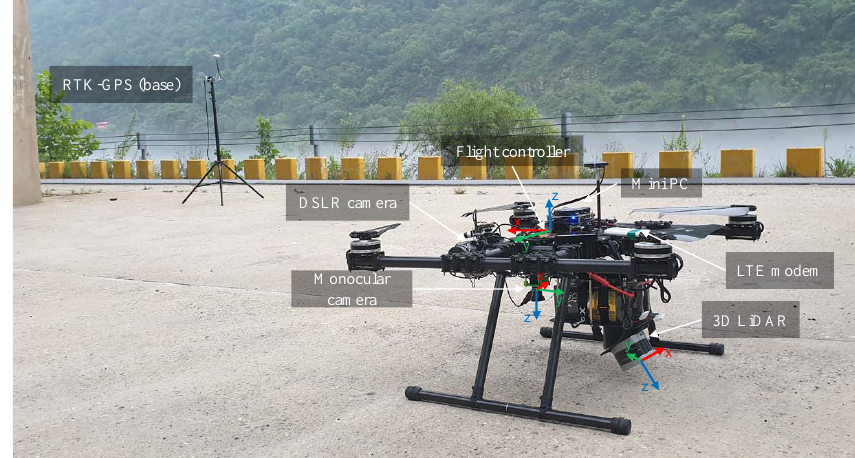
Figure 5. UAV used in this research. This custom-designed quadrotor-type UAV carries various sensors and devices. In the forward direction, a Sony α 9 DSLR camera is mounted on a homemade gimbal for bridge inspection. At the top is a PX4-based Pixhawk 2 flight controller with a Here + GPS (Global Positioning System) receiver. This GPS receiver is not used in the SLAM system being tested here, but is used later to convert the estimated local position of the drone into the global frame to serve as the ground truth when a GPS signal is available. An embedded Intel i7 NUC with 16 GB of RAM is also included for data processing. A 1280 × 1024 resolution monocular camera (PointGrey FL3-U3-13Y3M-C) is mounted in a downward-looking configuration. A 3D LiDAR system (Velodyne Puck LITE) is mounted with a tilt angle of 45 degrees at the rear of the UAV. It is also equipped with an LTE modem for remote communication, allowing the drone to be remotely operated wherever LTE communication is available.